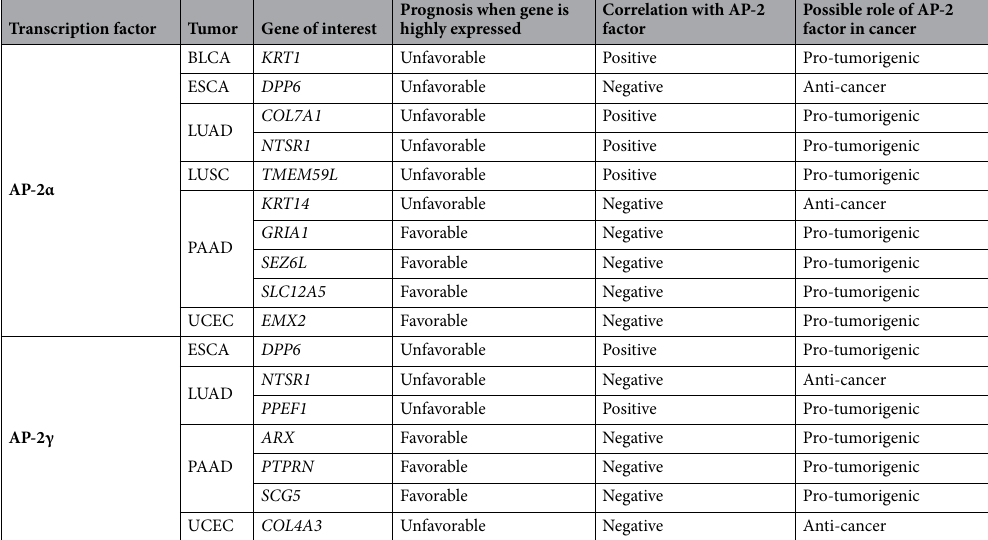
Table 2. Supposed role of AP-2α and AP-2γ in cancer based on genes that met the study requirements.